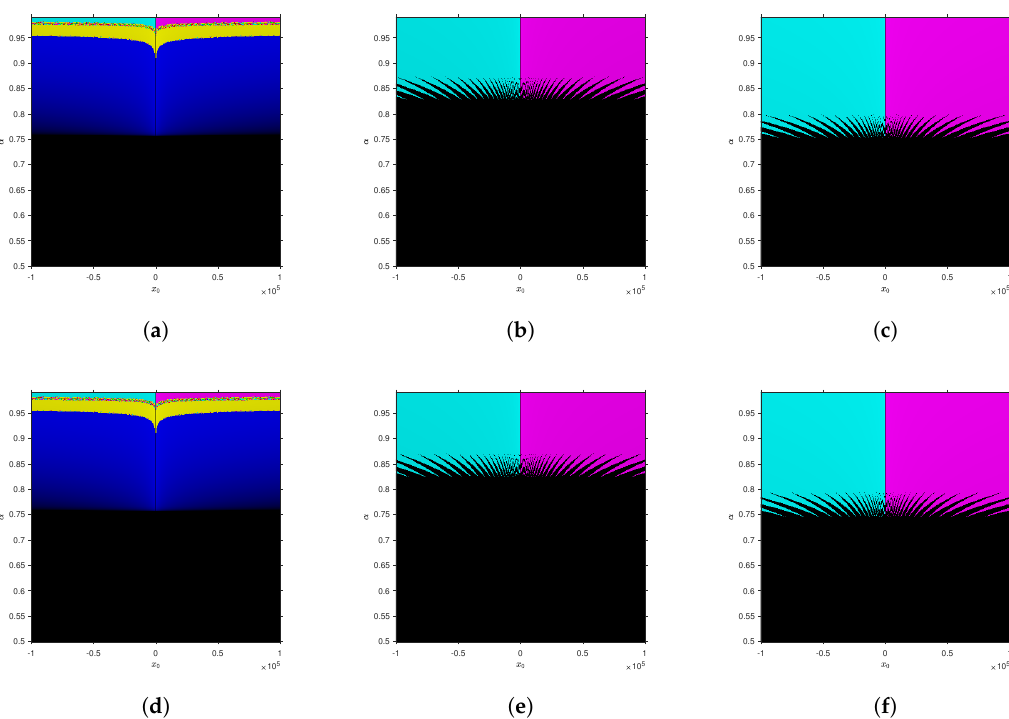
Figure 2. Convergence planes of fractional Newton and Traub-type on f 1 ( x ) with Re ( x 0 ) = 0 and − 10 5 ≤ Im ( x 0 ) ≤ 10 5 .